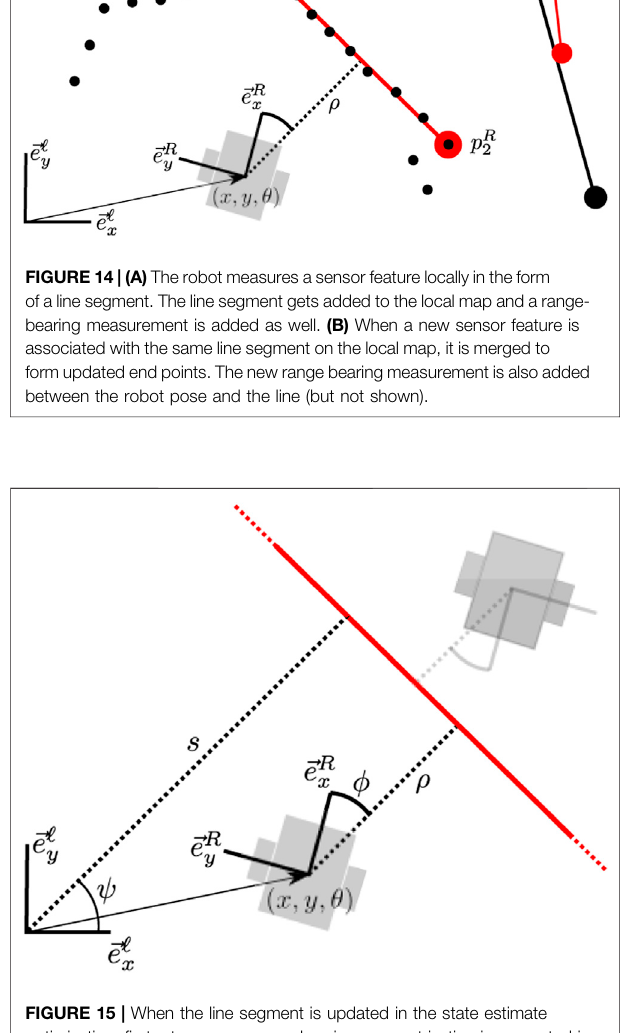
FIGURE 15 | When the line segment is updated in the state estimate optimization, fi rst a temporary range-bearing parametrization is generated in the local map as well to simplify calculation of measurement error and error